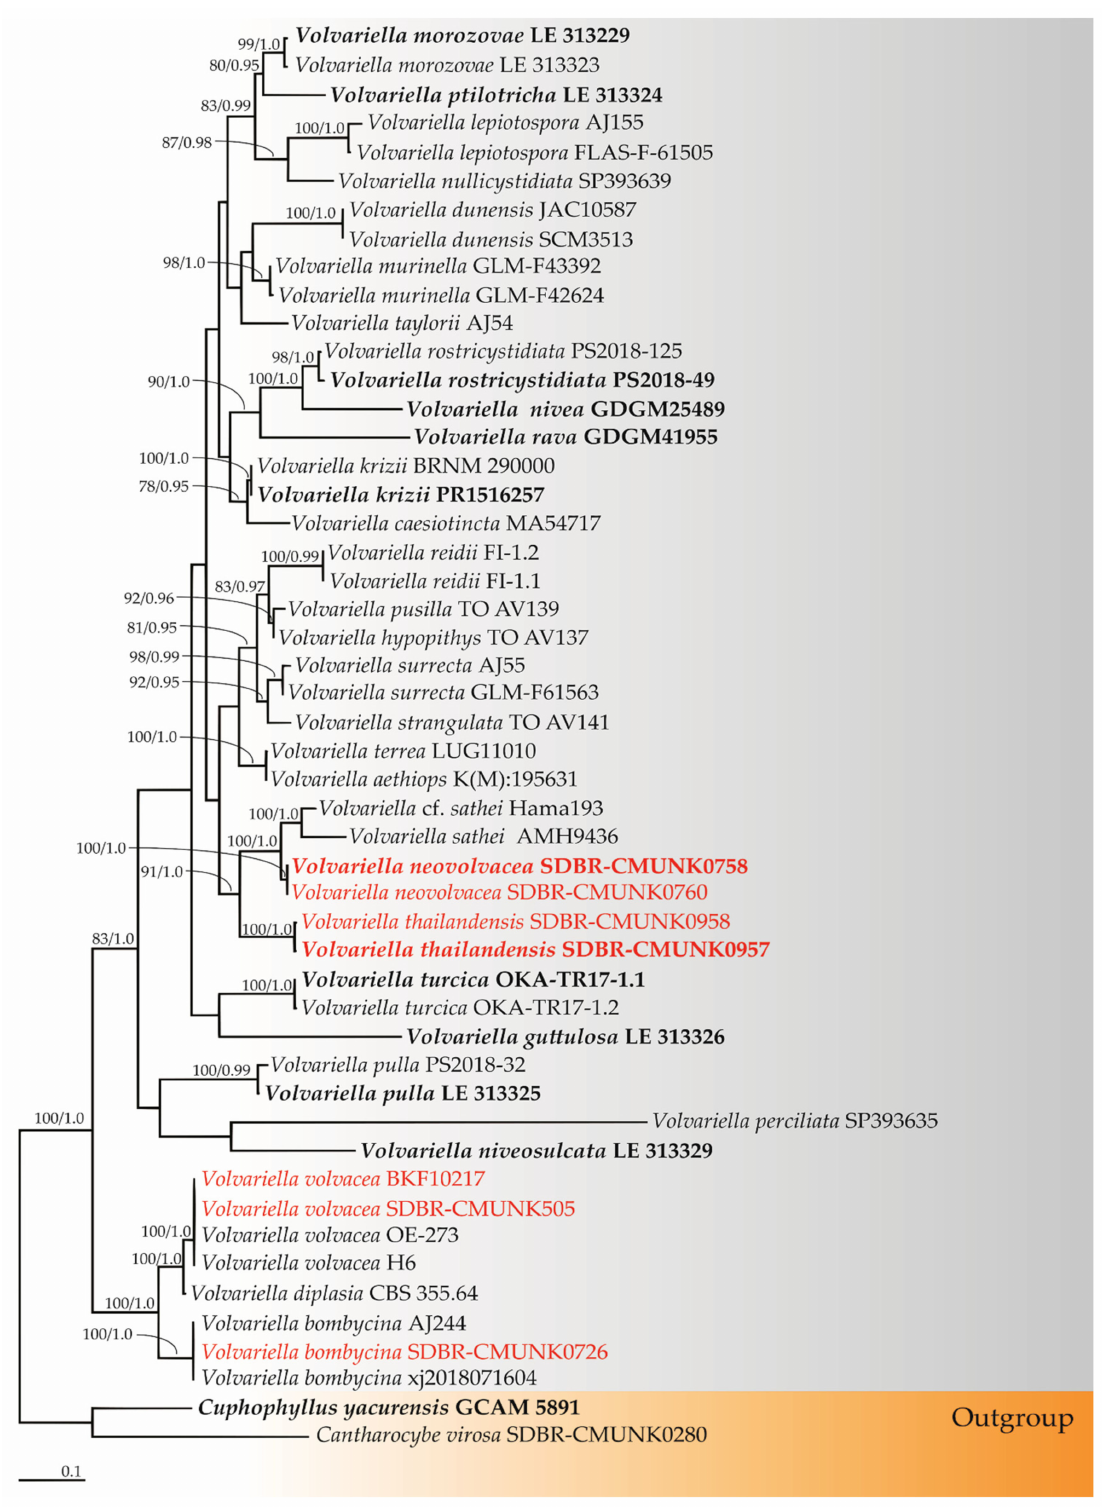
Figure 1. Phylogram derived from maximum likelihood analysis of 50 specimens of the combined ITS and nrLSU genes. Cantharocybe virosa and Cuphophyllus yacurensis were used as the outgroup. The numbers above branches represent bootstrap percentages (left) and Bayesian posterior probabilities (right). Bootstrap values ≥ 75% and Bayesian posterior probabilities ≥ 0.90 are shown. The scale bar represents the expected number of nucleotide substitutions per site. Sequences obtained from this study are in red. Type species are in